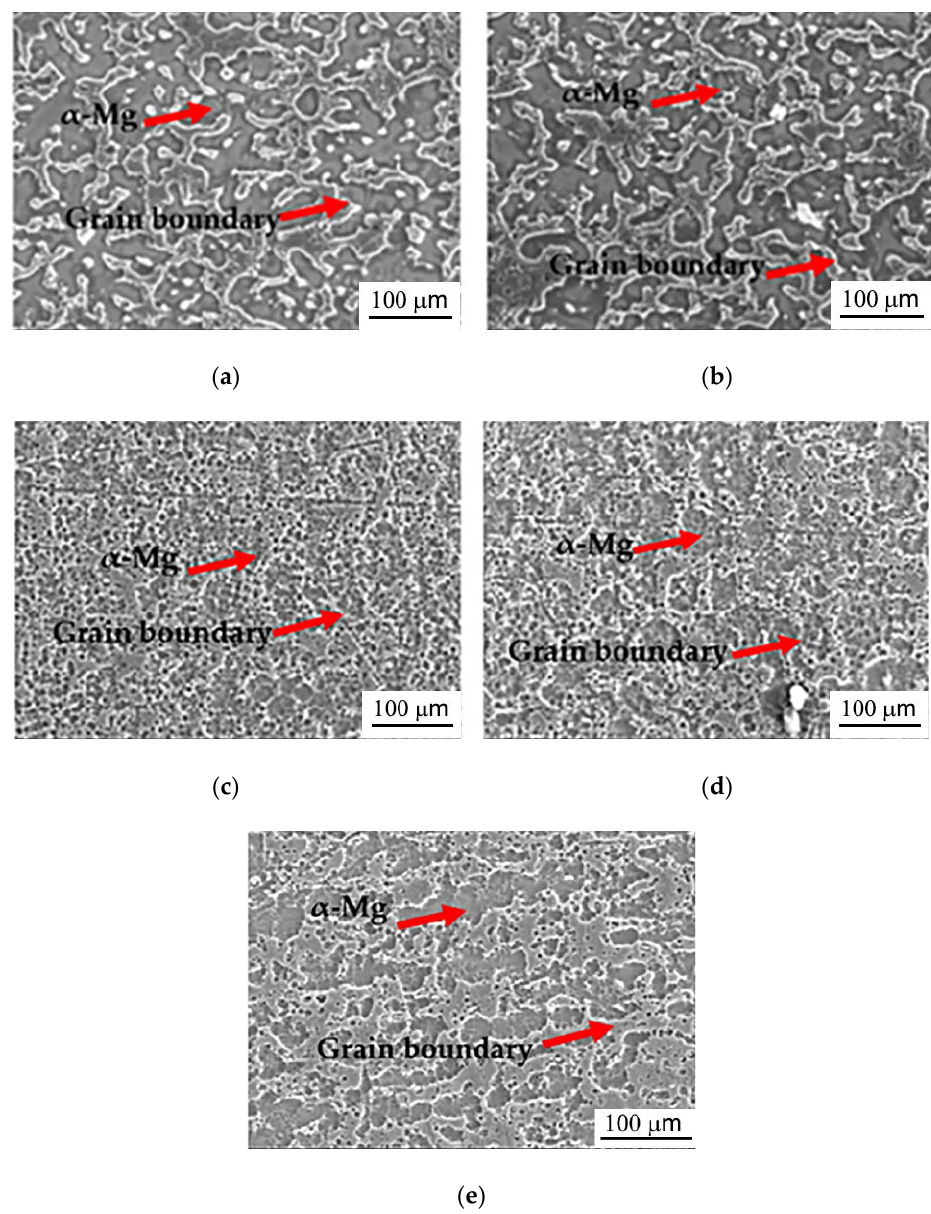
Figure 2. Microstructure of weld seam. ( a ) 1 mg/cm 2 ; ( b ) 2 mg/cm 2 ; ( c ) 3 mg/cm 2 ; ( d ) 4 mg/cm 2 ; ( e ) 5 ( e ) 5 mg/cm 2 mg/cm 2 .